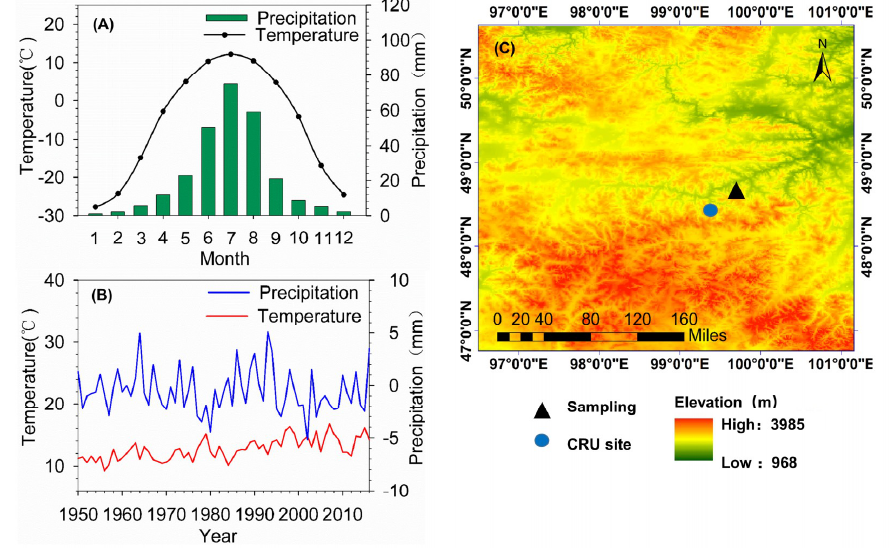
Figure 1. ( A ) Monthly mean temperature and precipitation of the study area from 1965–2016. ( B ) Annual of tree‐ring sampling site (triangle) and gridded data PDSI (circle). PDSI: Palmer Drought Severity